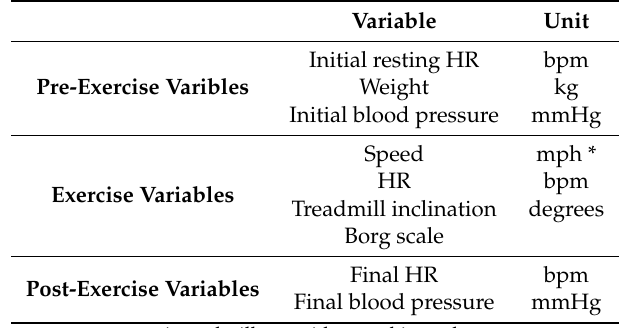
Figure 1. The therapy phases are illustrated: (1) Initial measurements and warming are performed during the first 10 to 15 min of the session. (2) The physical exercise is performed during 15 to 20 min, and finally (3) the cooldown and final measurement are performed during the last 10 to 20 min. Table 1. Measured variables in cardiac rehabilitation (CR) session at the local